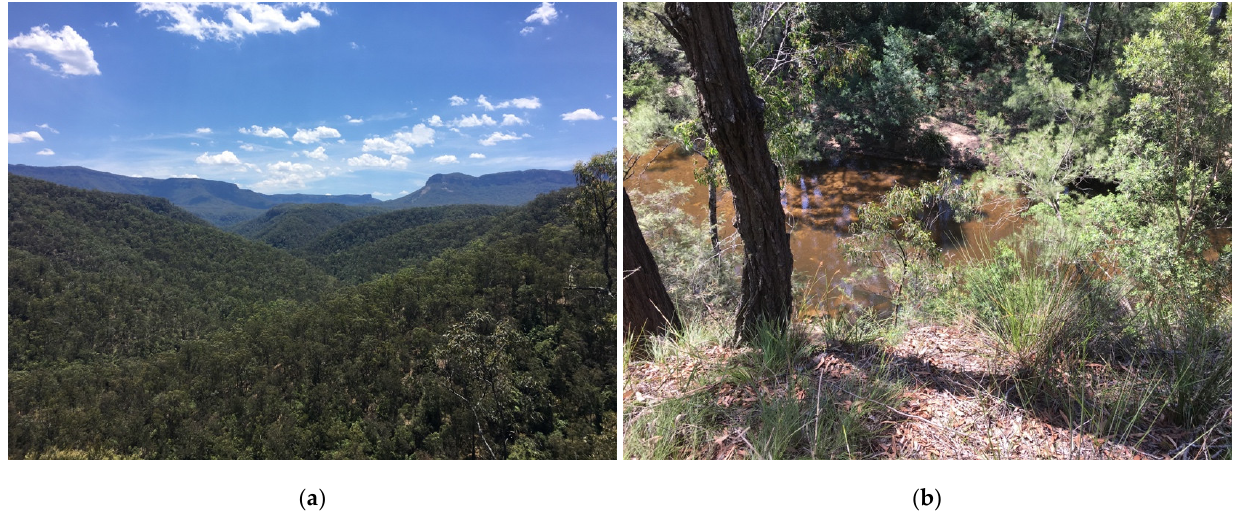
Figure 4. The predominant habitat and topography of Kedumba Valley: ( a ) Most of the region consisted of eucalyptus woodland across undulating and often steep terrain. ( b ) Most riparian corridors comprised steep cliffs making those sections of rivers inaccessible to horses. Images A.M. Harvey.